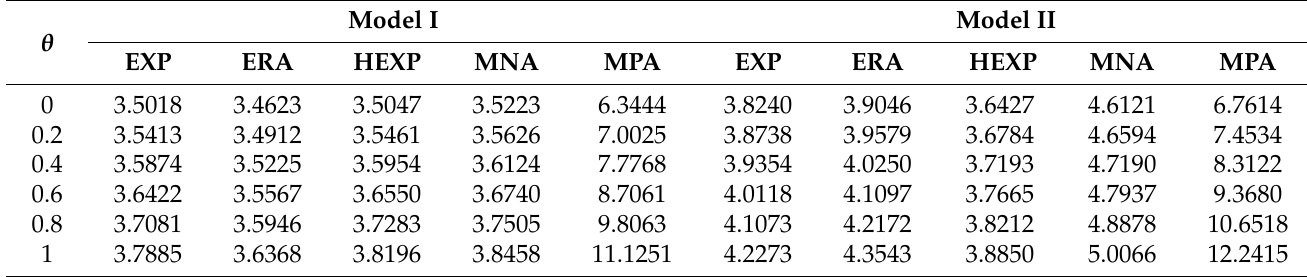
Table 8. Effect of θ on expected waiting time of P 2 customers in the system (when L =